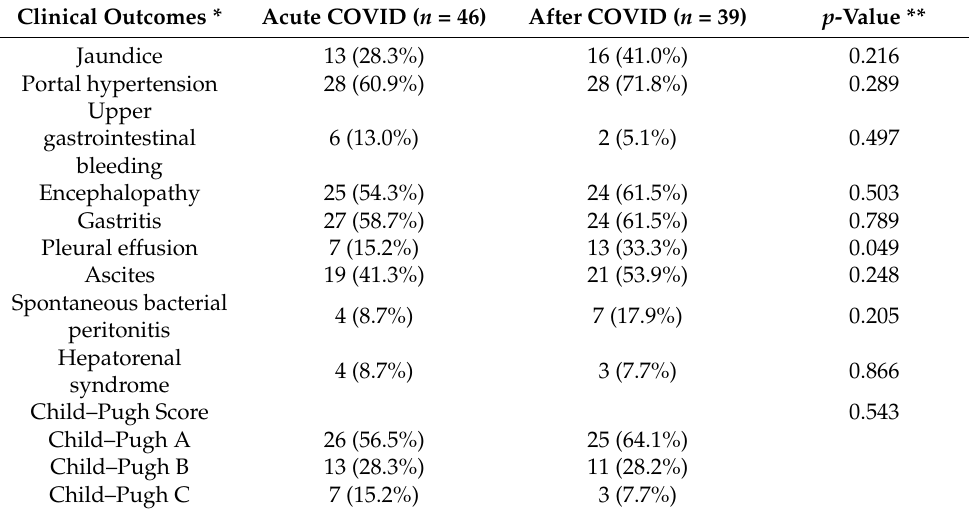
Table 4. Reevaluation of patients with cirrhosis at 4 weeks after SARS-CoV-2 infection.